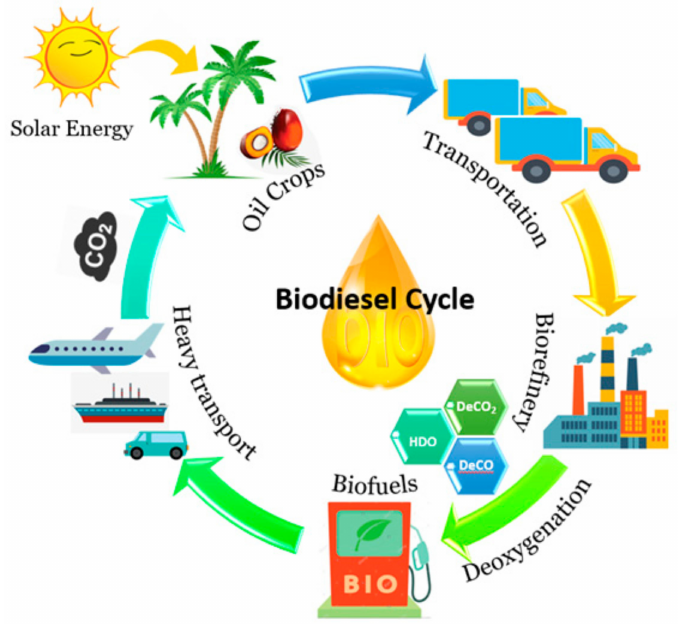
Figure 1. The life cycle of